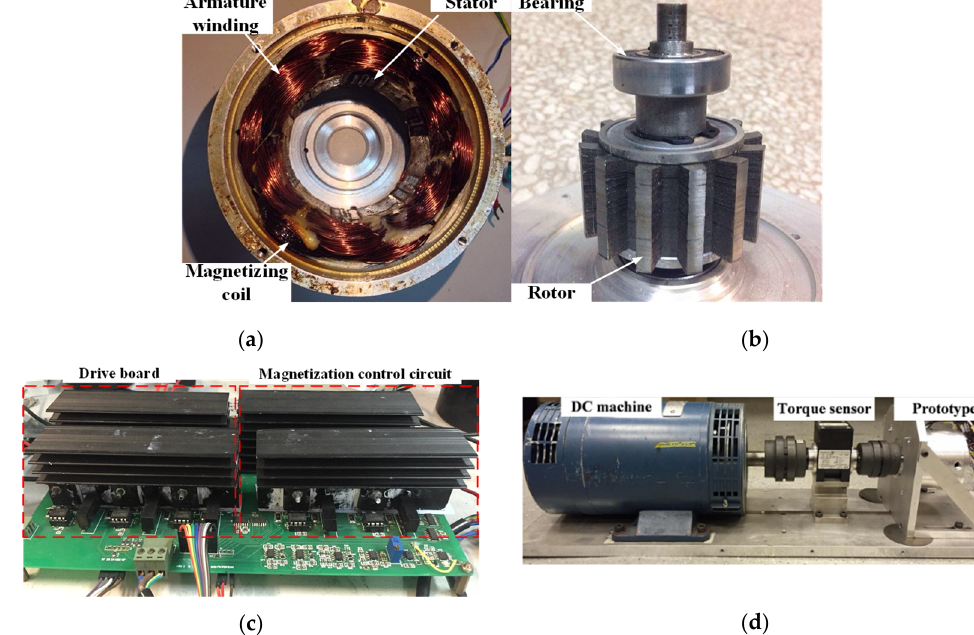
Figure 14. SF-HMMM prototype and test rig. ( a ) Stator. ( b ) Rotor. ( c ) The drive and magnetizing control board. ( d ) Test platform.